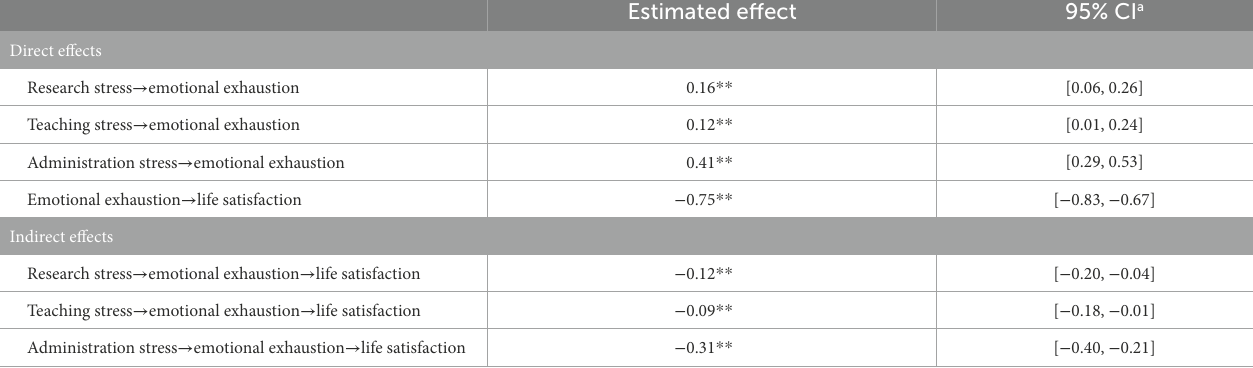
TABLE 4 Parameter estimates of the mediation model and 95% confidence